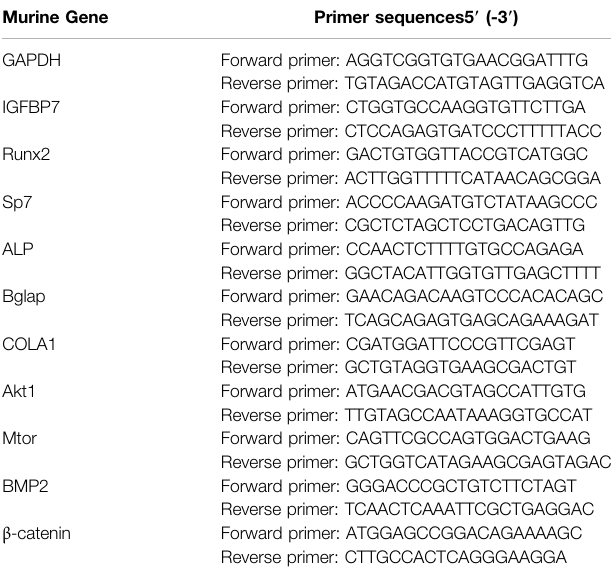
TABLE 1 | Primer sequences of target genes used in the real time-PCR analysis. Murine